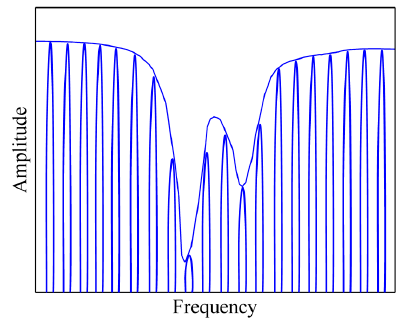
Figure 9. A schematic illustration of molecular spectrum capture.